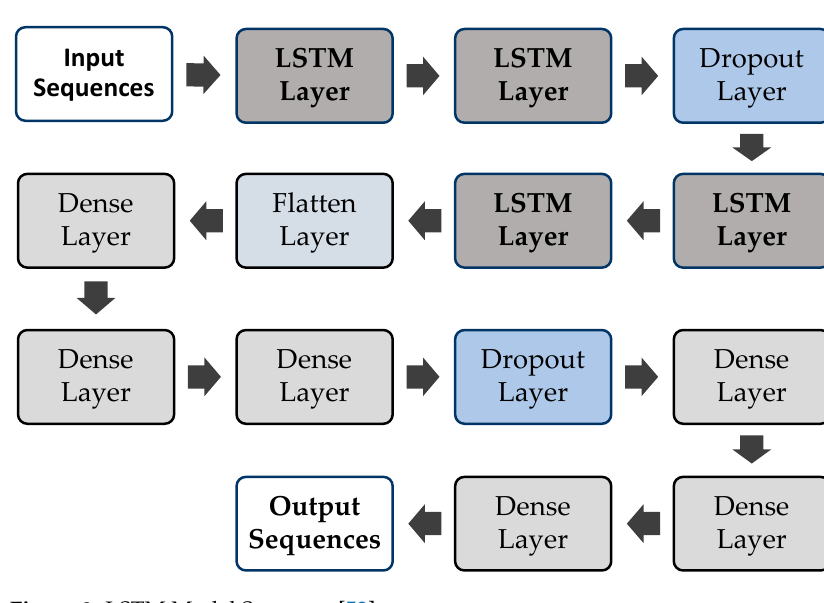
Figure 3. LSTM Model Structure [53].